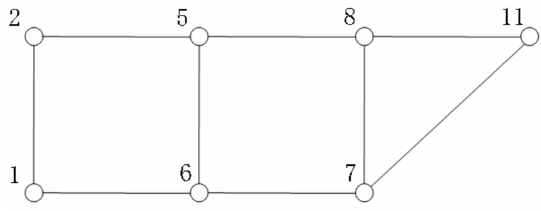
Figure 2. A simplified road network.